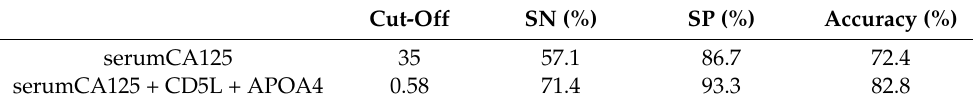
Table 9. The evaluation indicators of the model for diagnosis of ovarian cancer at early stages. Cut-Off